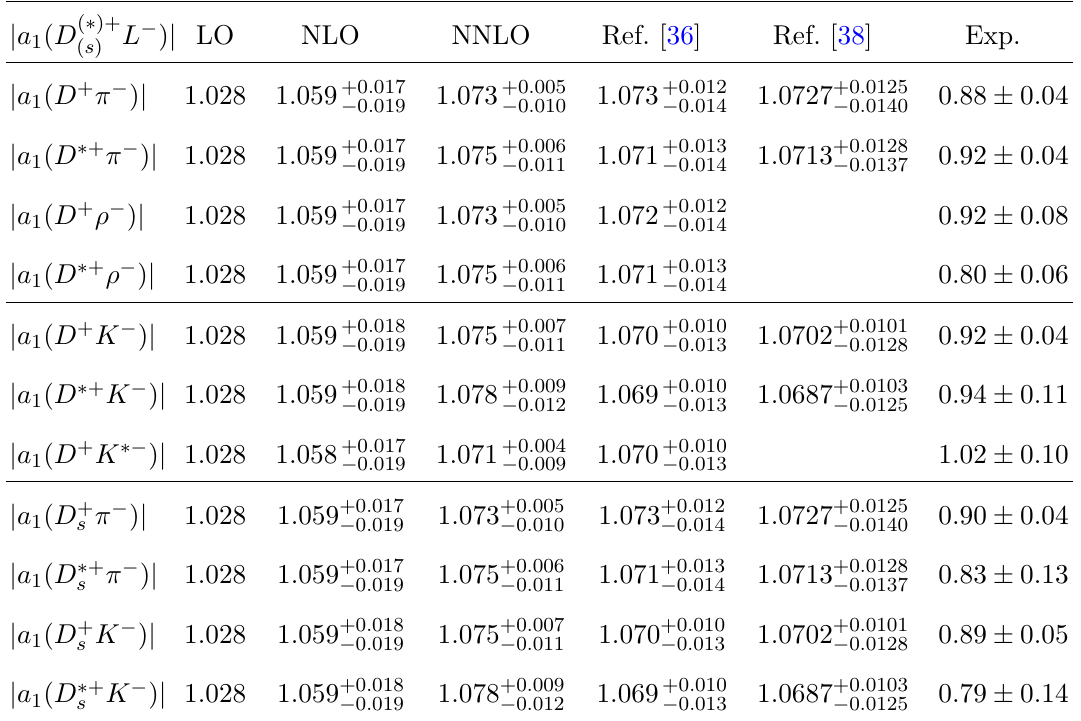
Table 5 . Theoretical and experimental values of the effective coefficients | a 1 ( D ( ∗ )+ perimental errors are estimated by adding the uncertainties of the non-leptonic branching ratios and the semi-leptonic differential decay rates in quadrature. Note that, at leading power in Λ QCD /m b , | a 1 ( D ( ∗ )+ L − ) | calculated within the QCDF framework depend only on the light meson L ( s )